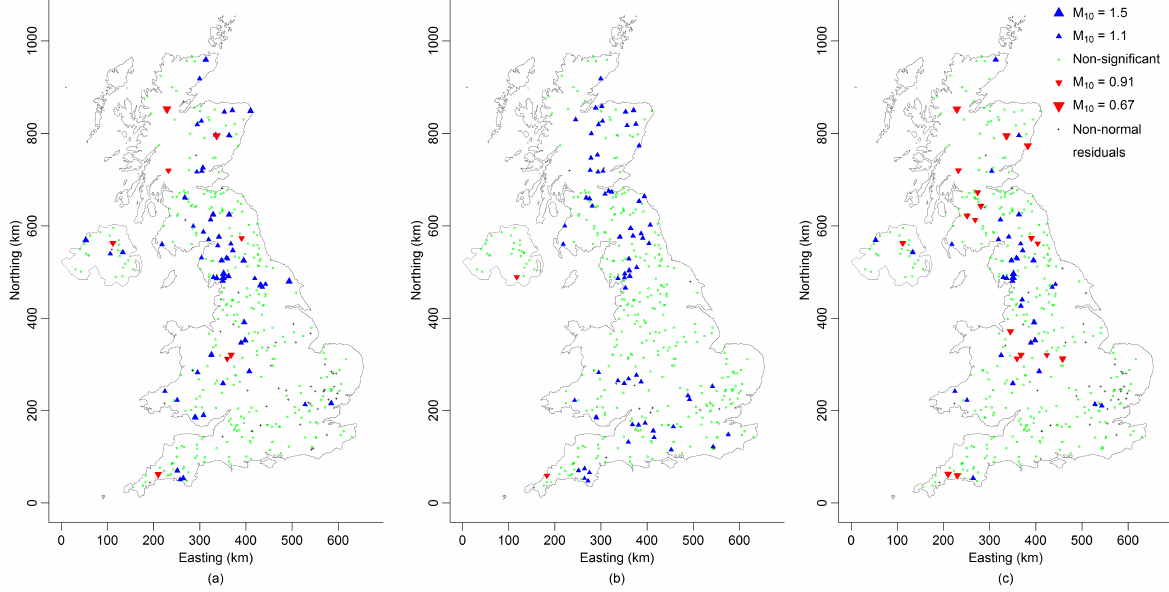
Fig. 9. Estimated decadal magnification factor M 10 for: (a) peak flow maxima with time as the only explanatory variable (model (a)), (b) daily rainfall maxima with time as the only explanatory variable, and (c) peak flow maxima with time and the 99th percentile of daily rainfall as explanatory variables – winter maxima